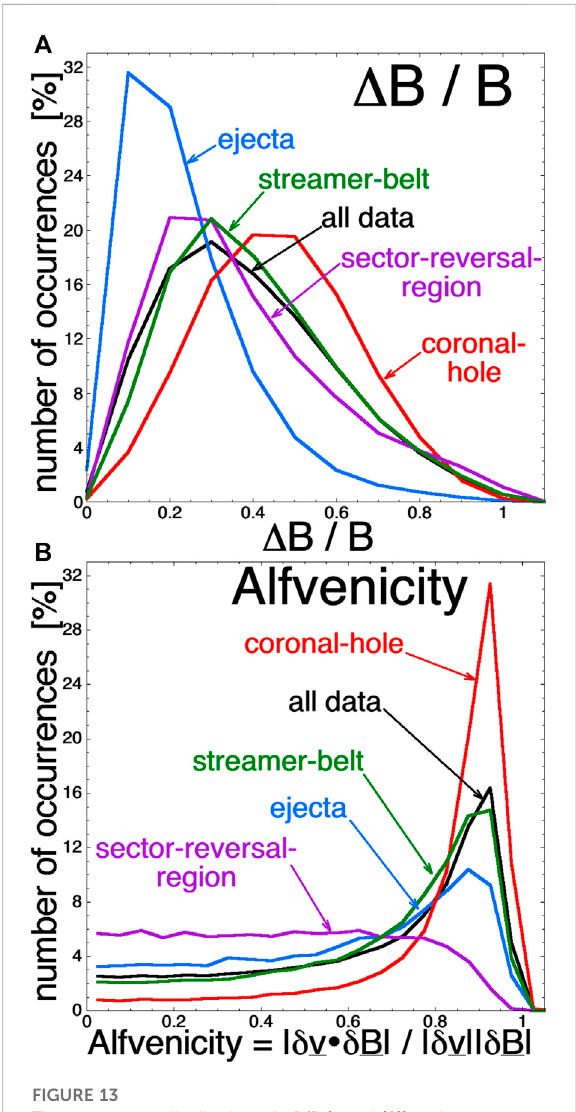
Figure 11B denotes the mean value of Hp60 1 in each bin: red (Hp60 1 > 2), yellow (1.5 < Hp60 1 < 2), green (1 < Hp60 1 < 1.5), and blue (Hp60 1 < 1). Both large Δ B/B and strong |A| seem upper-right corners of the plots where Δ B/B and |A| are largest.